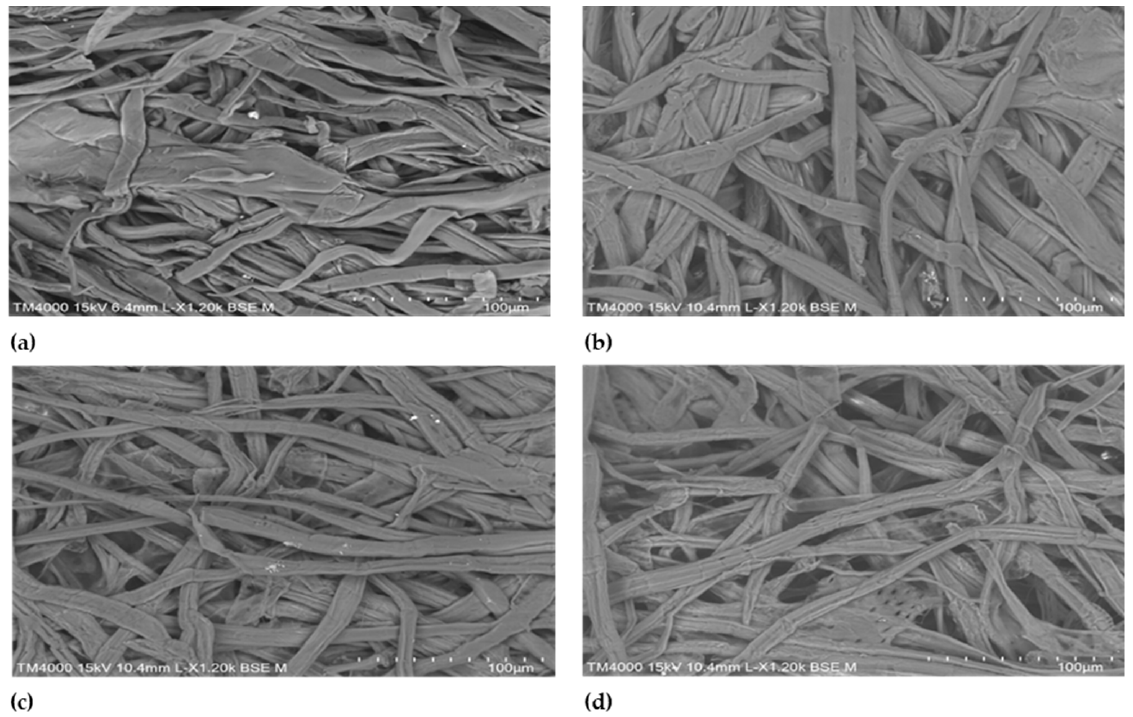
Figure 1. SEM images of pulp fibres following treatment of oxygen-delignified eucalypt kraft pulp with: ( a ) control 30 min; ( b ) control 60 min; ( c ) X 30 min, 75 g/t odp; ( d ) X 60 min, 25 g/t odp.